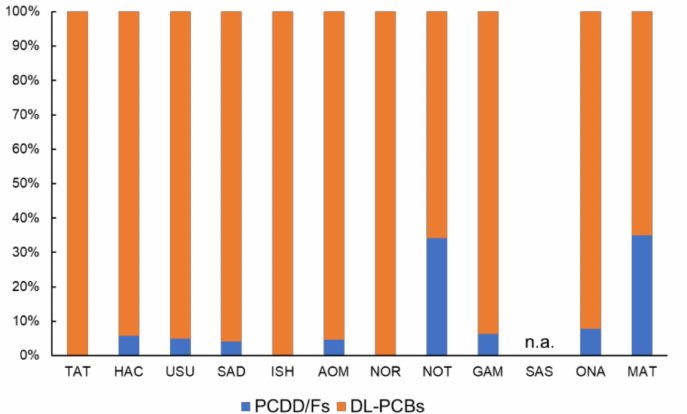
Figure 6. Proportion of PCDD/Fs and DL-PCBs on total TEQ at 11 sampling